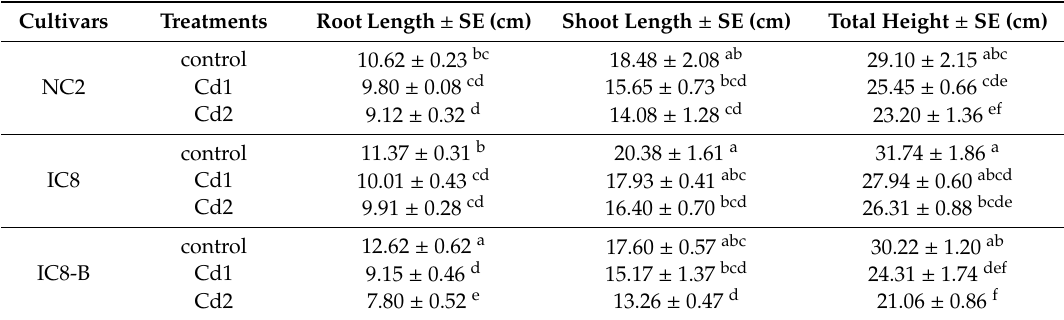
Table 1. Root and shoot length, and total plant height of chickpea seedlings grown in a nutrient medium under Cd stress at the rate of 0 µ M (control), 25 µ M (Cd1) and 50 µ M (Cd2) with mean values ± SE, ( n = 3).